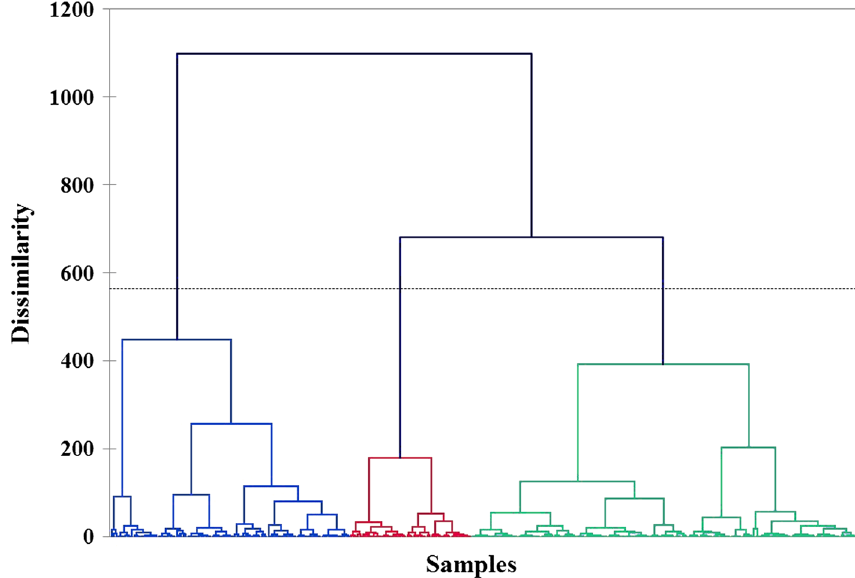
Fig. 4 Ward’s dendrogram of treated wastewater samples in their PC